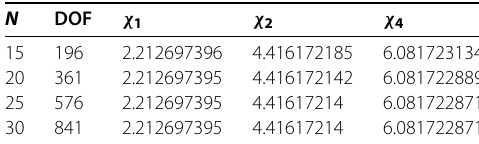
¯ (cid:3) Table 1 The approximative eigenvalues on = [0, π /2] 2 N DOF χ 1 χ 2 χ